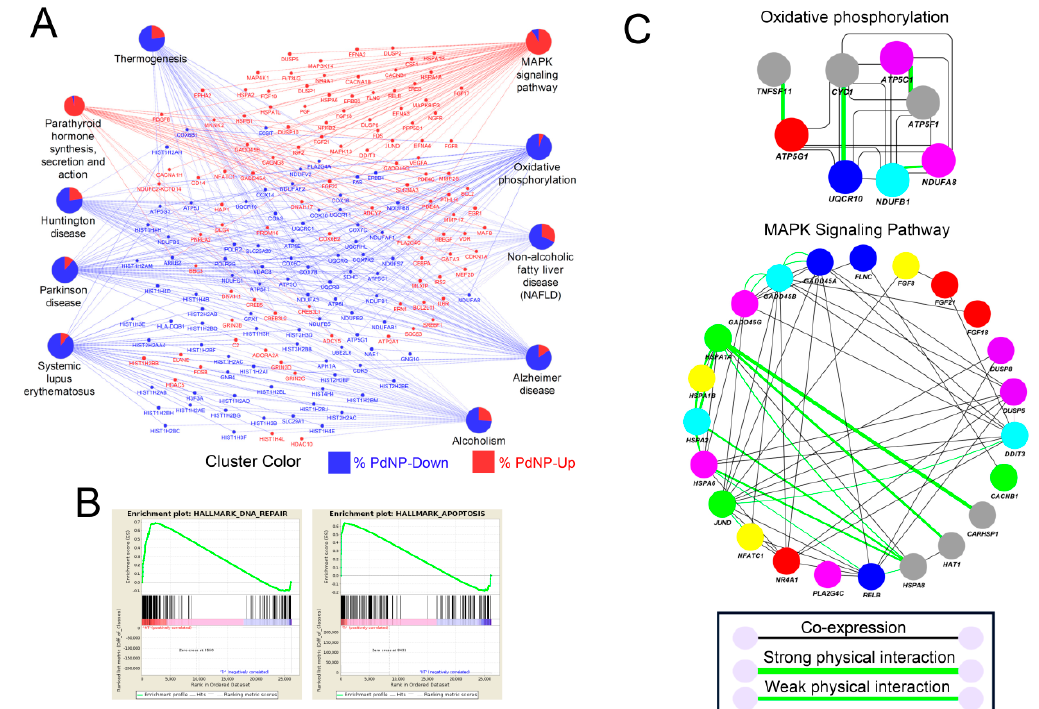
Figure 11. Pathway analysis reveals the dysregulated expression of apoptosis-inducing genes. ( A ) Kyoto Encyclopedia of Genes and Genomes (KEGG) analysis showing interconnected genes in the biological pathways. Red and blue colors represent genes respectively up- and downregulated by palladium nanoparticles (PdNPs). ( B ) Gene set enrichment analysis (GSEA) showing enriched pathways with both up- and downregulated genes. Note that DNA repair and apoptosis pathways were both detected within the differentially expressed genes (DEGs). ( C ) GeneMANIA analysis showing the gene co-expression network (grey lines) and protein–protein interactions (light green lines) in the KEGG pathways (oxidative phosphorylation and MAPK signaling pathway).